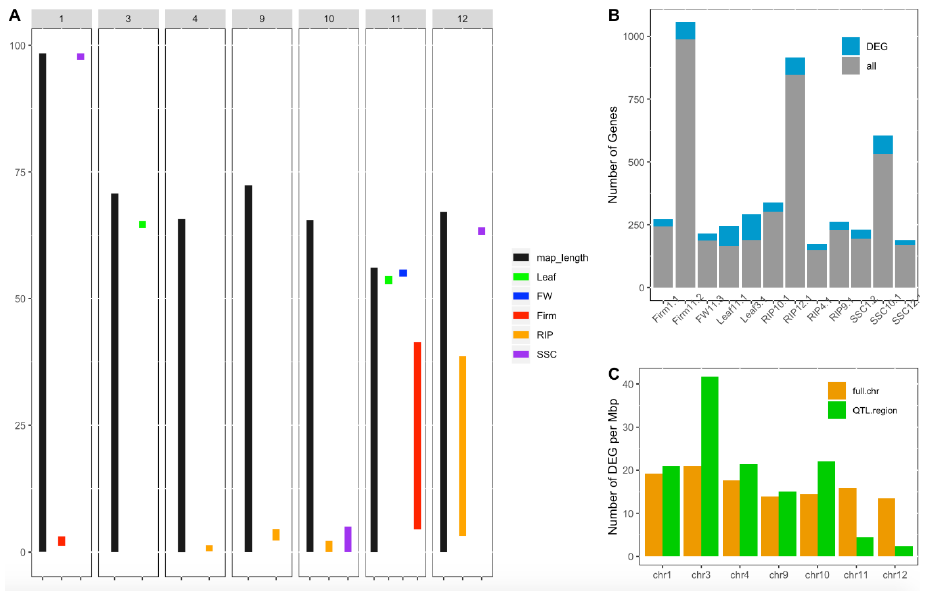
Figure 4. Candidate gene screening for tomato plasticity quantitative trait loci (QTLs). ( A ) Position in Mbp of WD-responsive QTLs identified in the multi-allelic MAGIC population in Diouf et al. (2018). Black bars represent the chromosome length and colored bars represent confidence interval regions of the plasticity QTLs for different fruit traits assessed: fruit weight (FW), fruit firmness (Firm), fruit ripening (RIP), soluble solid content (SSC), leaf length (Leaf) and flowering time (flw). ( B ) Number of genes within the whole CI region of the QTL (in gray) and number of genes showing significant differential expression under water deficit (in blue). ( C ) Number of DEGs per Mbp within the whole chromosome (in orange) and within the regions covered by QTLs per chromosome (in green). QTL detection using the parental haplotype probabilities in the MAGIC population allows for the estimation of the allelic effect for each parental line at every QTL position. Correlation analysis was further investigated between the allelic effect and expression level across the eight genotypes. The expression of a total of 46 genes showed significant correlation with the QTL allelic effect, reinforcing their potential implication in regulating fruit phenotype variation under WD (Table S4). The whole process of candidate gene selection is depicted in Figure 5 for the QTL RIP9.1 as an example.